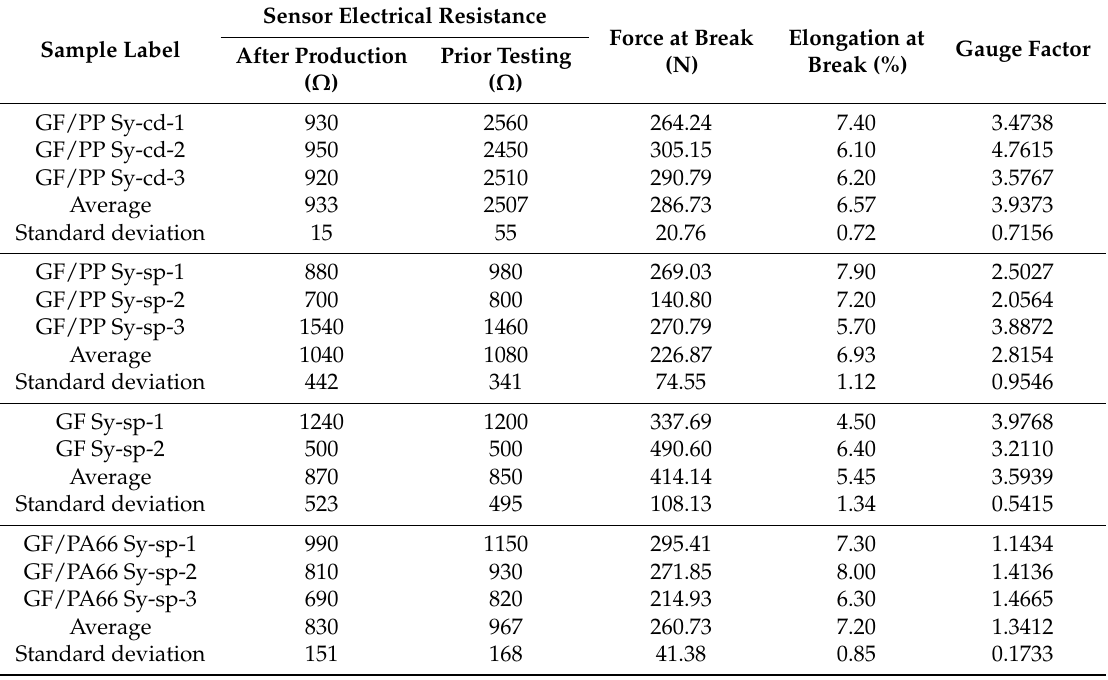
Table 7. Electromechanical tests of textile sensors: sensor electrical resistance, tensile results and gauge